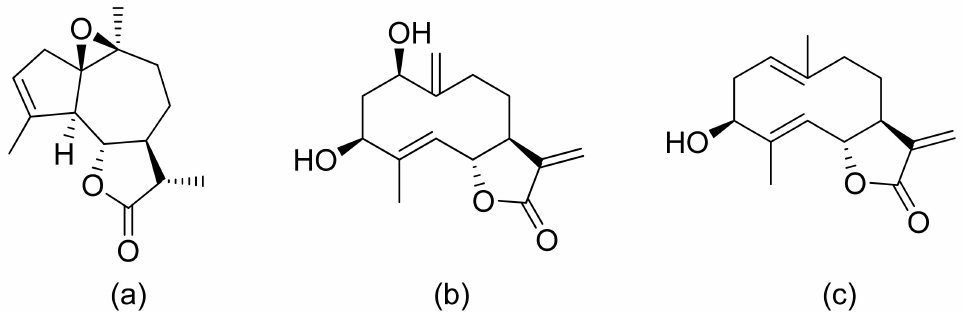
Figure 17. Antiplasmodial compounds from Artemisia gorgonum ( a – c